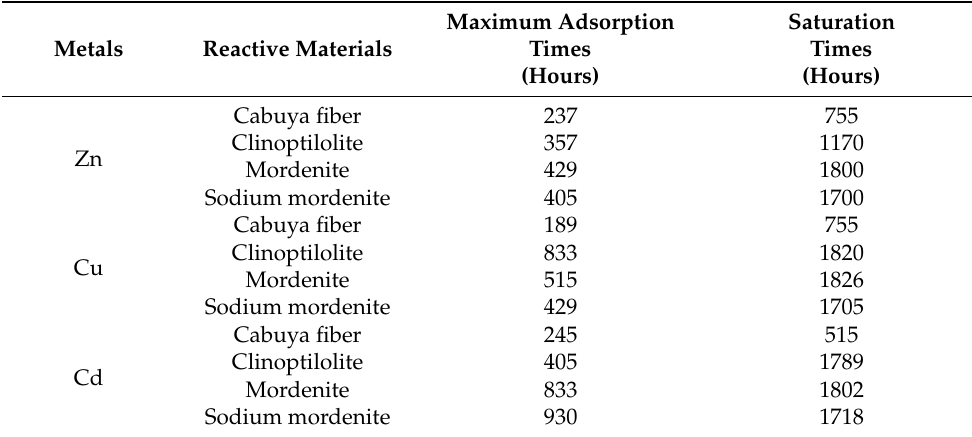
Table 6. Maximum adsorption times and saturation times of Zn, Cu and Cd, for each reactive material considered.